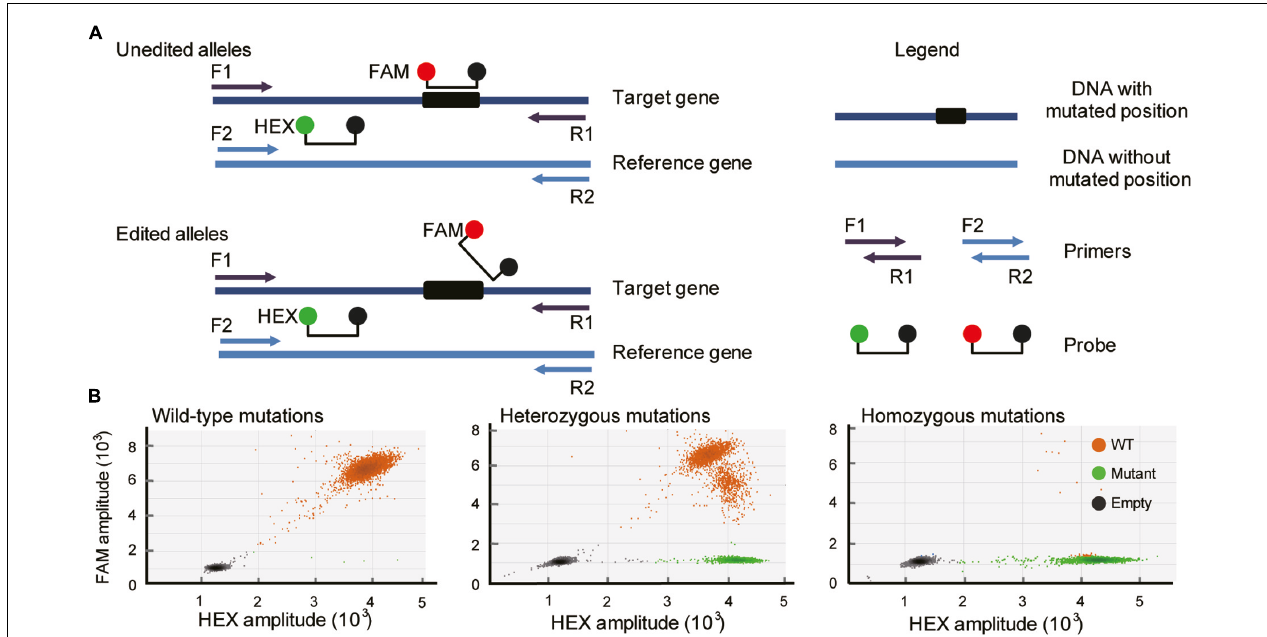
FIGURE 1 | Development of a dPCR platform for detection of gene editing. (A) Schematic illustrates the dPCR-based assay (primers F1 and R1 span the DNA with mutated position; primers F2 and R2 span the DNA without mutated position). Amplicons are detected by the activation of amplicon-specific fluorescent probes. A FAM-labeled probe locates at the mutation position, and a HEX-labeled probe locates without mutation position. (B) Three typical droplet plots of the wild-type mutations (WT; right panel), heterozygous mutations (middle panel), and homozygous mutations (right